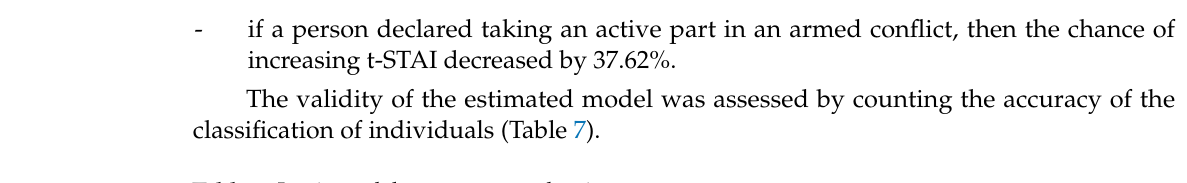
Table 6. Logit model parameter evaluations.